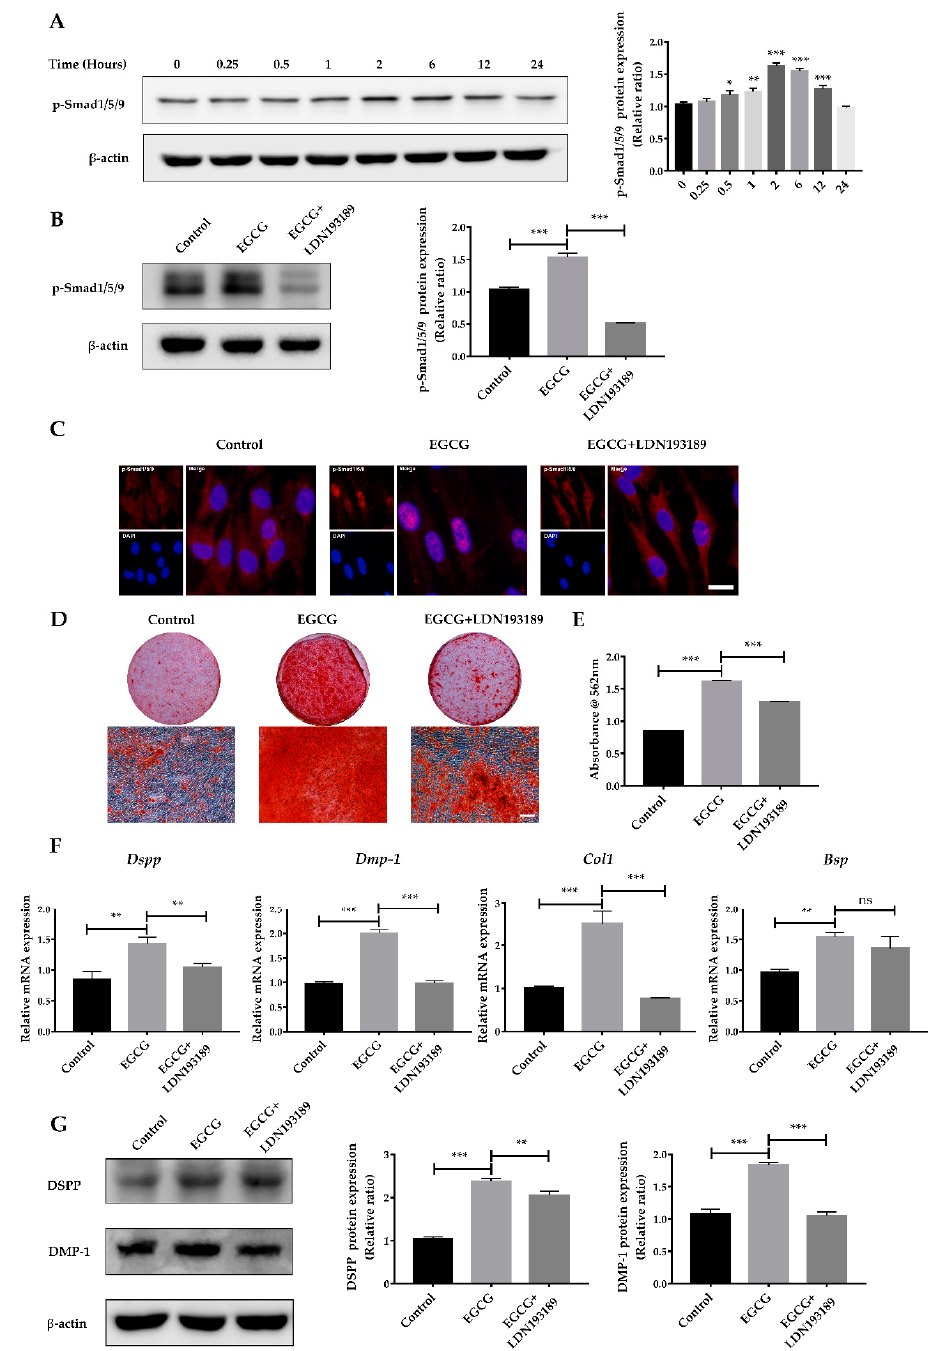
Figure 5. The BMP–Smad signaling pathway is involved in EGCG-stimulated osteo-/odontogenic differentiation. ( A ) The phosphorylation level of Smad1/5/9 in SCAPs treated with EGCG at different time points and the quantitative analysis. ( B ) Western blot analysis showing the increased phosphorylation of Smad1/5/9 was reversed by LDN193189. ( C ) Im- munofluorescence staining indicating EGCG increased the translocation of p-Smad1/5/9 from the cytoplasm into the nucleus, but LDN193189 inhibited this transference. Scale bar = 20 µ m. ( D ) ARS staining in the control (0 µ M) group, EGCG (1 µ M) group, and EGCG+LDN193189 group after 14 days of induction. ( E ) Semi-quantification of calcium deposits. ( F ) The gene expression levels of Dspp , Dmp-1 , Bsp , and Col1 in inhibitor group (EGCG+LDN193189) were suppressed compared with in the EGCG group ( n = 3). ( G ) The protein levels and quantitative analysis of DSPP and DMP-1 at 14 days. Error bars: mean ± standard deviation. (* p < 0.05, ** p < 0.01, *** p < 0.001, ns: not statistically